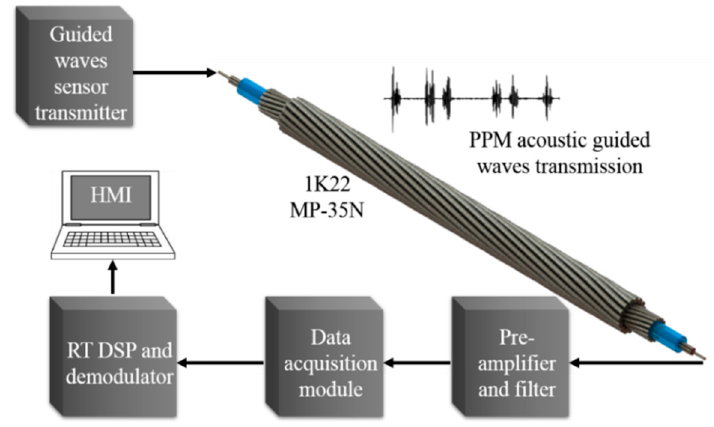
Figure 4. Automatic data transmission guided waves communication system block diagram.